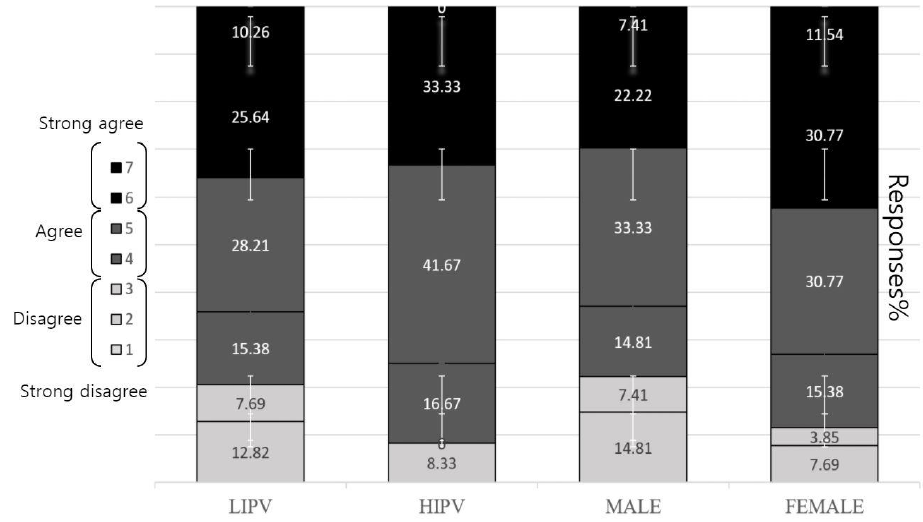
Figure 11. The level of enjoyment referred to the answers of (Post-Q.4) in post-questionnaire.